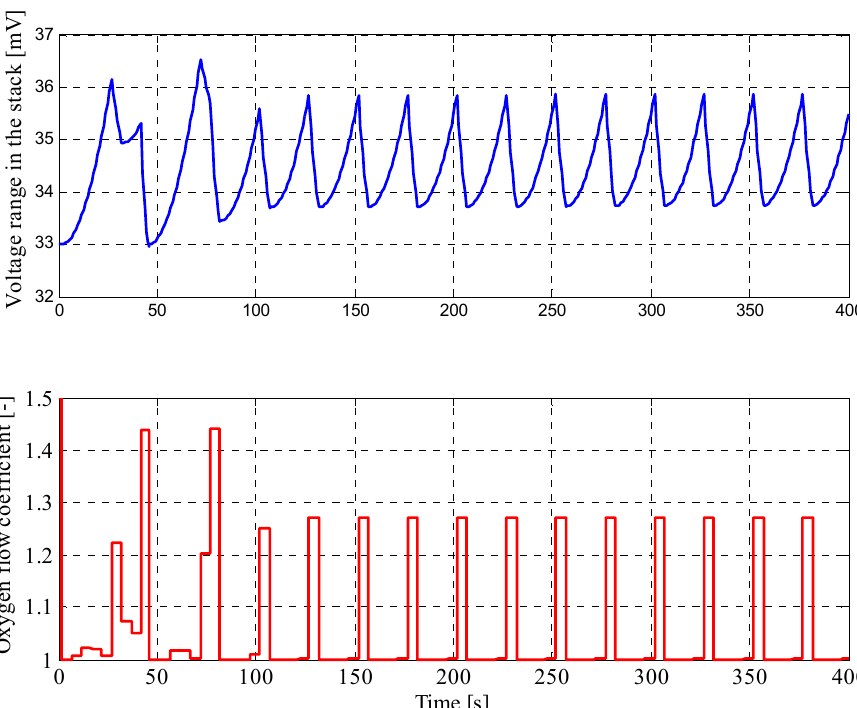
Figure 16. Voltage range and oxygen flow coefficient for the optimized by GA fuzzy control procedure with simulation parameters set to R U , z = 35 mV and ∆ t = 5 s (initial R U = 33 ( mV ) , k O 1.5 ).